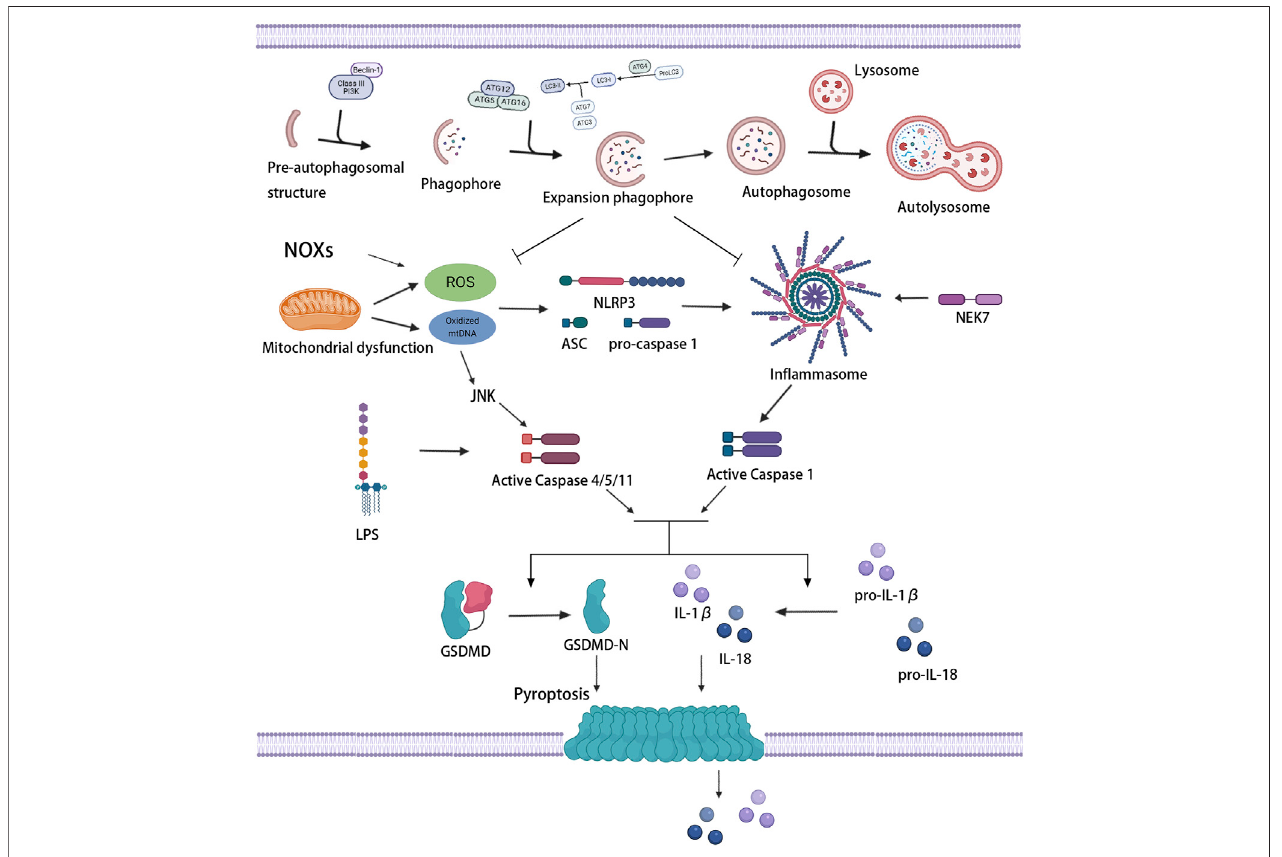
FIGURE 4 | Association between autophagy and pyroptosis. Mitochondrial dysfunction and NOXs induce the massive production of ROS and stimulate the activation of in fl ammasome and caspase-1. LPS and oxidized mtDNA induce caspase-4/5/11 activation. Activated caspase-1/4/5/11 cleaves GSDMD, induces pyroptotic cell death, and promotes the release of IL-1 β and IL-18. Mild oxidative stress triggers off autophagy, which inhibits in fl ammasome signaling and ROS production, thus protecting against pyroptosis.